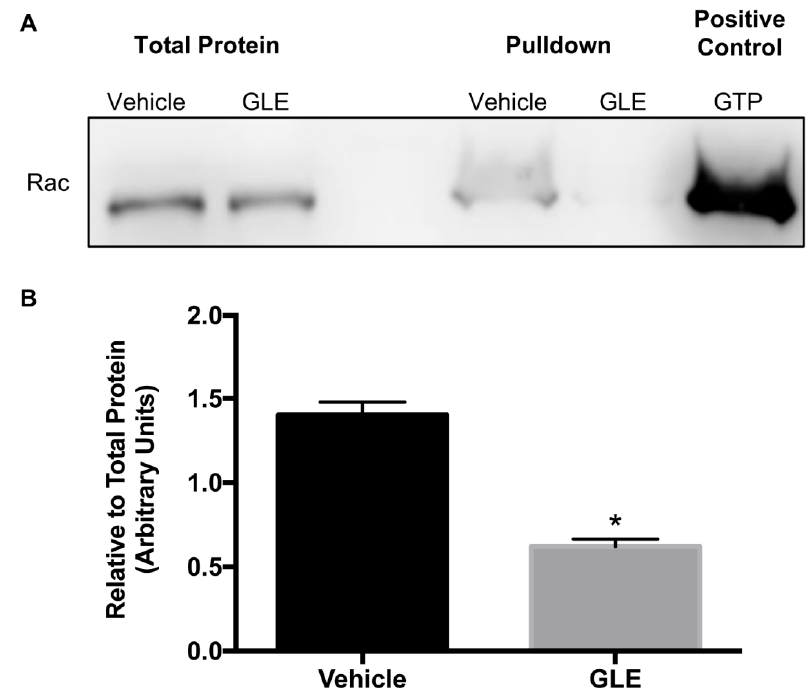
Figure 3. GLE decreases Rac activity in MDA-MB-231 breast cancer cells. ( A ) MDA-MB-231 cells were treated with vehicle or GLE (0.96 mg/mL) for 24 h. Total lysates were obtained and incubated with PAK-PDB beads to precipitate active Rac by a pulldown activation assay. The total protein lysates and pulldowns were analyzed by Western blot. GTP was used as a positive control to test activity of the beads. ( B ) Densitometry analysis of western blot bands. Quantification was done using integrated density units and Rac activity was calculated relative to total protein expression. Data are expressed as mean ± SEM. Experiments represent data obtained from three independent biological replicates. Statistically significant difference is shown at * p < 0.05 compared to vehicle.